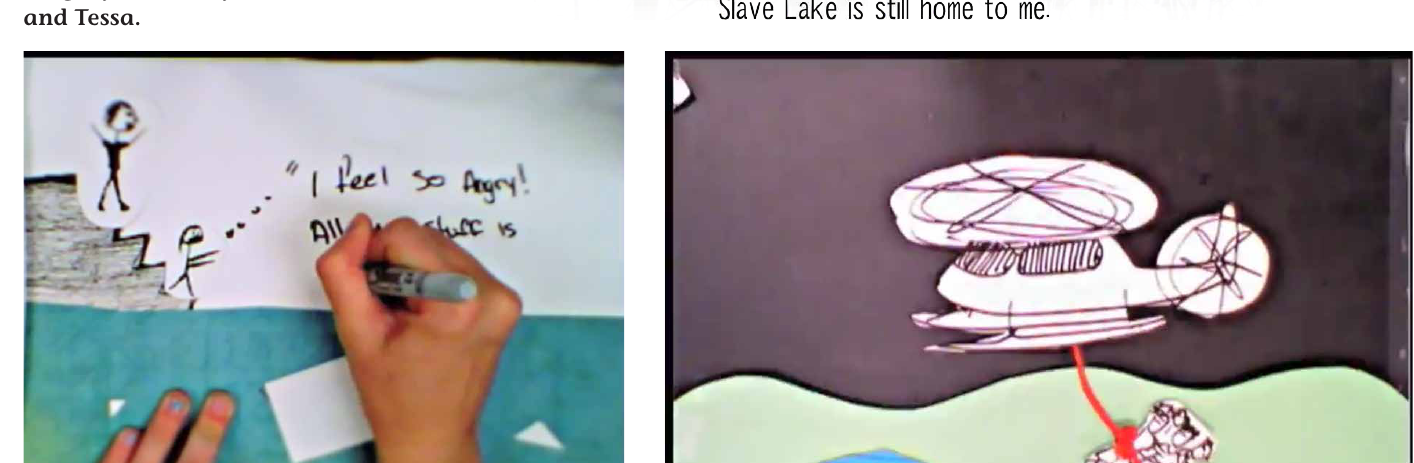
Figure 6: Slave Lake participants created face- painting photo-art to depict recovery in relation to their changed environment, which led to in-depth discussions about their recovery experiences.